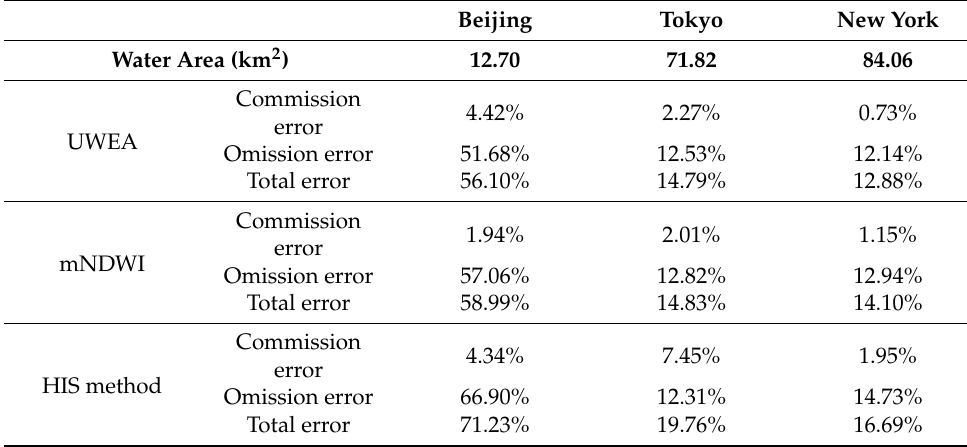
Table 3. The classification accuracy for the whole city.